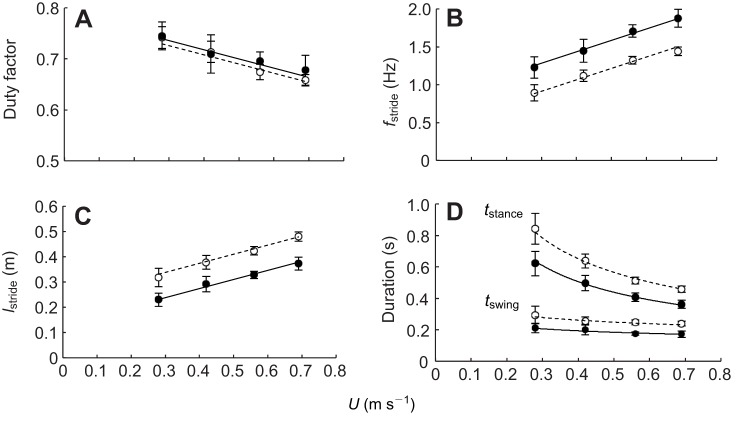
Relationships between kinematics parameters and walking speed U. Filled circles and solid lines represent data for bantam leghorns and open circles and dashed lines represent data for large leghorns. The lines of best fit are (A) duty factor=−0.18U+0.79 (bantam) and −0.18U+0.78 (large); (B) stride frequency, fstride=1.51U+0.83 (bantam) and 1.51U+0.46 (large); (C) stride length, lstride=0.36U+0.13 (bantam) and 0.36U+0.23 (large); and (D) swing time, tswing=0.16U−0.22 (bantam) and 0.21U−0.22 (large); and stance time, tstance=0.28U−0.64 (bantam) and 0.36U−0.64 (large). Data points are means±s.d. (s.e. are not large enough to be seen).